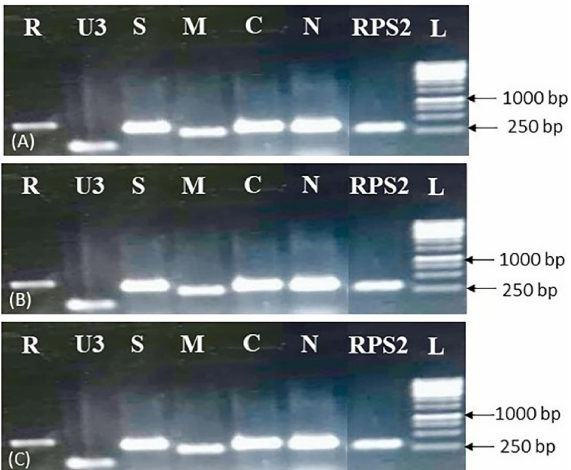
Figure 3. RT-qPCR amplification of BBTV transcripts. L = GeneRuler 1 kb DNA ladder (Thermo Scientific, Vilnius, Lithuania), RT-qPCR amplified fragment of DNA-R, -U3, -S, -M, -C, -N, and RPS2 banana gene from Leaf ( A ), Midrib ( B ), and Root tissues ( C